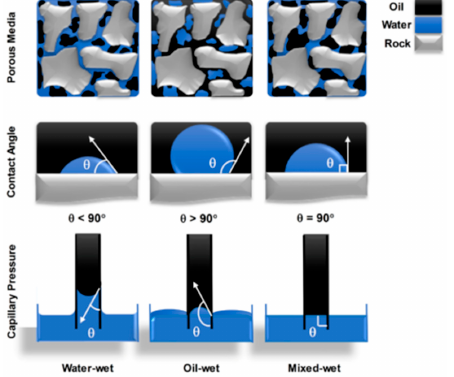
Figure 2. Schematic definition of wettability in porous media with oil/water/rock system illustrating water-wet, oil-wet, and mixed-wet conditions in terms of contact angle and capillary pressure [15]. 3. The Main Groups of Chemical Reagents There are four main groups of surfactants, which are divided by the nature of the hydrophilic group: anionic, cationic, nonionic, and zwitterionic [16]. However, the use of different types of surfactants together in one composition due to the compound effect, in comparison with single surfactant use, is often more effective in reducing interfacial and surface tension. This is because various surfactants allow the solubilization of various components of oil. Thus, the quality features and properties of the outcome composition are altered and expanded by adding different types of surfactants. According to the re- search [17], this effect is related to the presence of specific interactions between molecules or ions of different types. However, these interactions can either increase or decrease the effect of the compound at the interfaces. As a result, due to the various component com- pounds of crude oil and applied surfactants, individualized studies are required to clarify the possible effects. 3.1. Anionic Surfactants These surfactants are often used in chemical flooding projects because of their wide- spread all over the world, the possibility of altering their properties, and their reasonable cost. This group includes an extremely wide range of molecular structures with different functionalities, but we considered the most commonly used. 3.1.1. Alkyl Aryl Sulfonates Alkyl aryl sulfonates were first presented to the global market in the 1930s–1940s and they became the main industrial surfactants in 1945. The most significant drawback of these surfactants is their lack of natural biodegradability. Moreover, it has been estab- lished that these surfactants are not very stable in conditions of increased water hardness or in the presence of divalent ions (e.g., Mg, Ca). On the other hand, alkyl aryl sulfonates retain their stability in high-temperature formations [16]. Therefore, it is necessary to use alkyl aryl sulfonates in compounds with other surfactants or in compounds with co-sol- vents to improve their withstanding ability in harsh conditions.